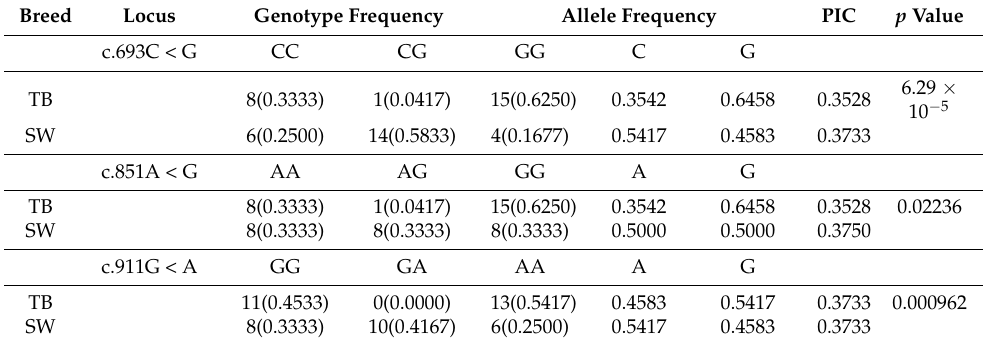
Table 6. Allelic and genotypic distribution of the MLPH gene in four rabbit breeds. Breed Locus Genotype Frequency Allele Frequency PIC p